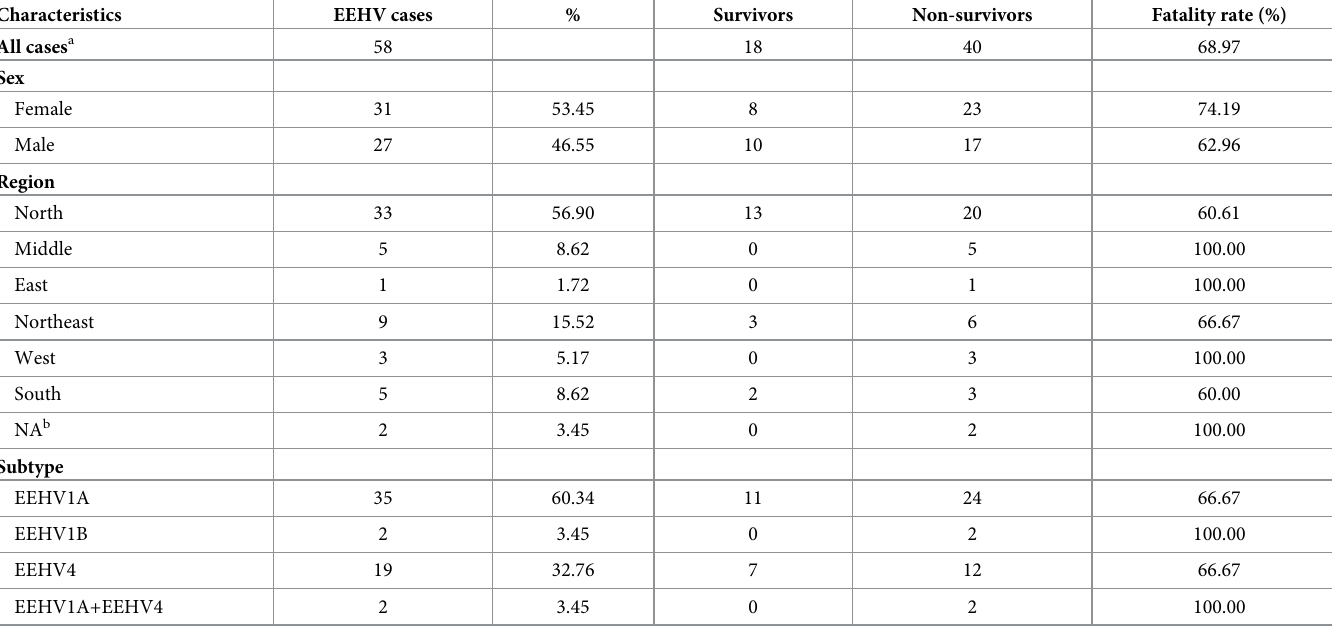
Table 1. Demographic characteristic of 58 confirmed EEHV cases in Thailand between 2006 and